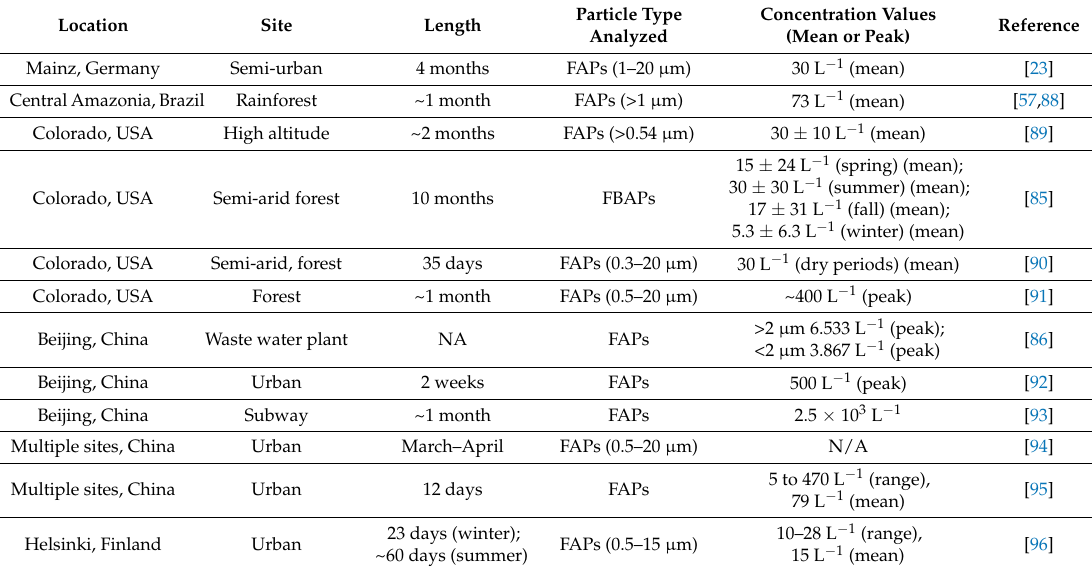
Table 2. Published studies of ambient Fluorescent Biological Aerosol Particles (PBAP) detected by Ultraviolet Aerodynamic Particle Sizer